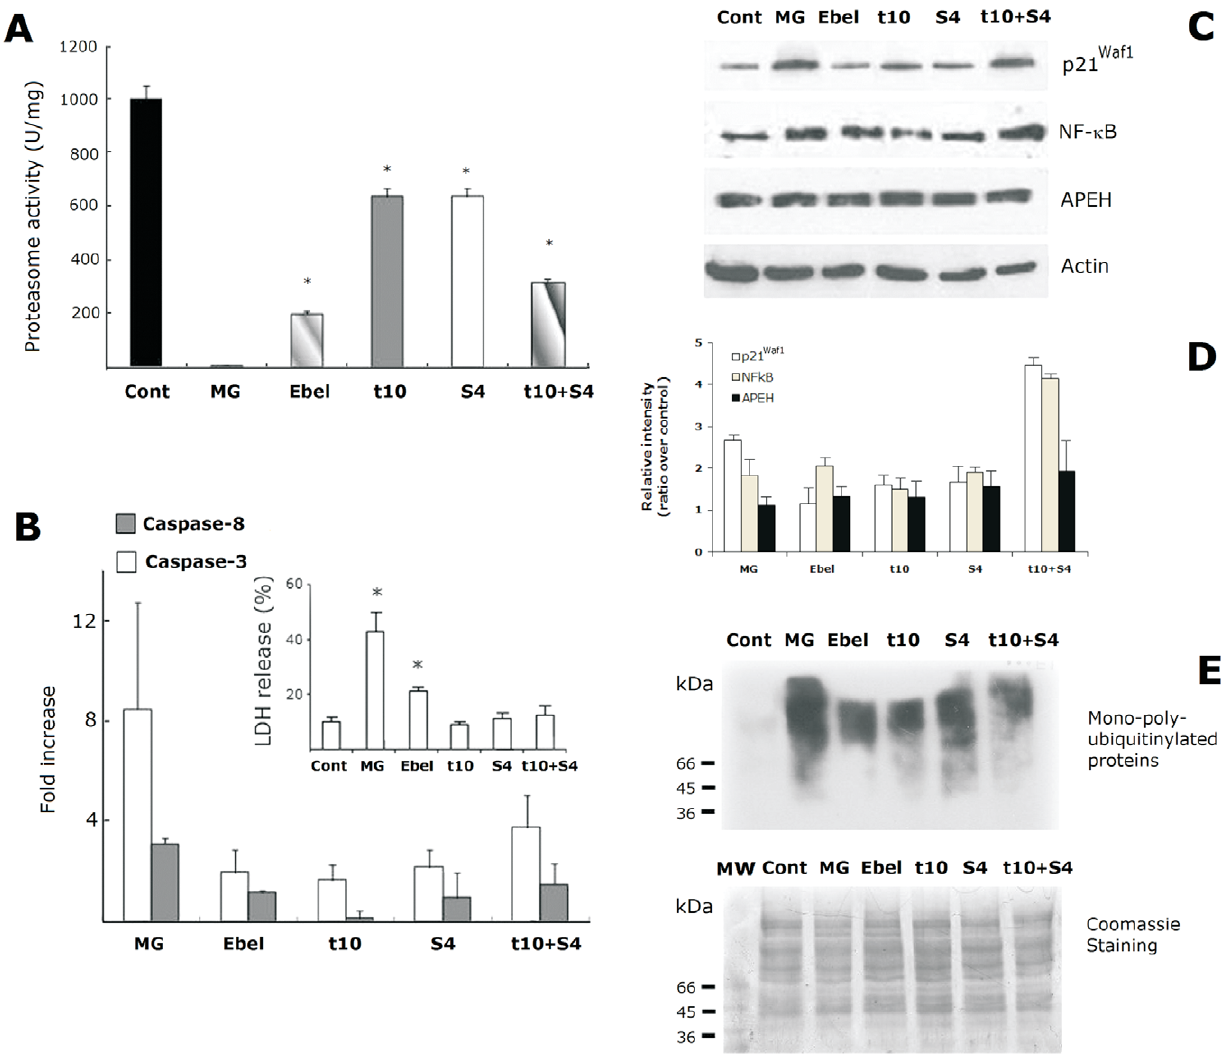
Figure 4. Evaluation of proteasome inhibition markers in Caco-2 cells incubated with SsCEI-4 and t 10 c 12 -CLA, alone or in combination. Caco-2 cells were treated (48 h) with 10 m M MG132 (MG), 100 m M ebelactone (Ebel), 200 m M SsCEI 4 (S4), t 10 c 12 -CLA (t10), or with a mixture of both (t10 + S4). Cells exposed to DMSO alone were used as the controls (black bar). The data are expressed as means 6 SD. *Significantly different ( P , 0.005) from the control (A). Caspase-3 (white bars) and caspase-8 (grey bars) activities measured as fold increase in comparison to untreated cells (B). The cytotoxic effect of the different treatments was evaluated by measuring the LDH release in the culture media (B insert). Representative immunoblots of the expression of p21Waf1, NF- k B, and APEH in Caco-2 cell exposed for 48 h to MG, Ebel, S4, t10 or with a mixture of both (t10 + S4) (C). Data on Western blot analysis are expressed as the density ratio of target to control ( b -actin) in arbitrary units. The values were expressed as average relative intensity as compared to untreated cultures and expressed as means 6 SD of measurements performed in triplicate (D). Protein ubiquitinylation in Caco-2 cell exposed for 48 h to MG, Ebel, S4, t10 or with a mixture of both (t10 + S4) (E, upper panel). Upon the immunodetection, the membrane was stained with Coomassie blue. The lane loaded with molecular mass markers [MW kDa] was shown (lower panel).